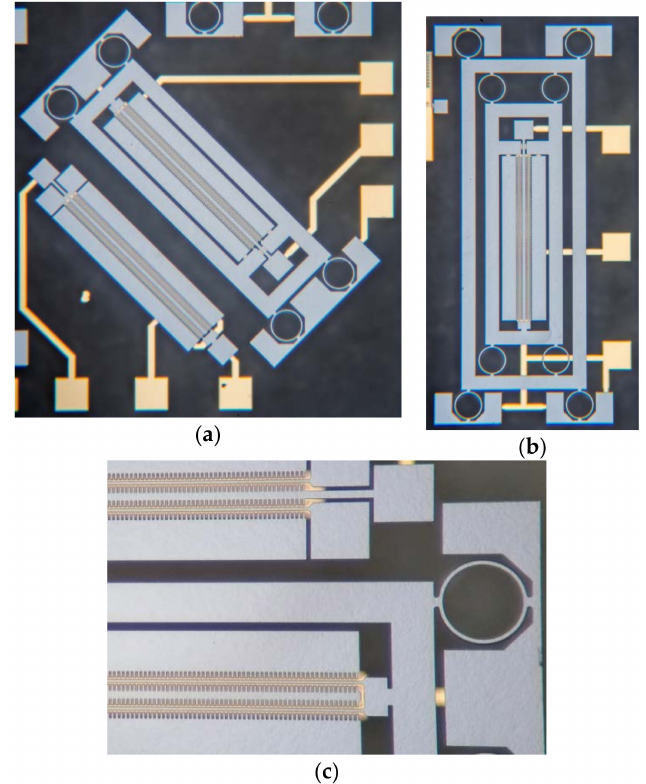
Figure 5. The DETFs and stress isolation structures. ( a ) Stress test structures of orientation <100> with and without stress isolation; ( b ) stress test structure of orientation <110> with 2-stage stress isolation; and ( c ) the details of the DETF structure of orientation